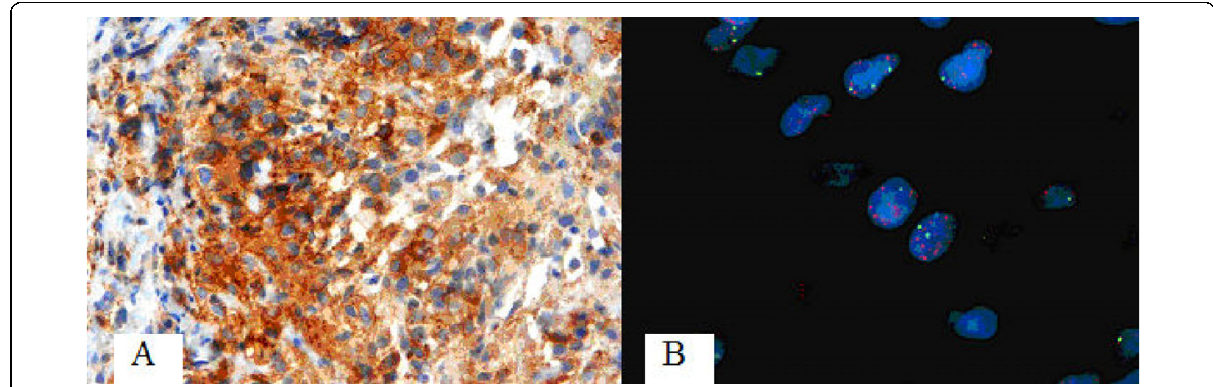
Figure 1 (A) Positive immunoreactivity for c- erb B2 (clone CB-11) (40×). (B) FISH analysis showing EGFR gene amplification (Chromosome 7 centromeric probe in green, EGFR probe in red).